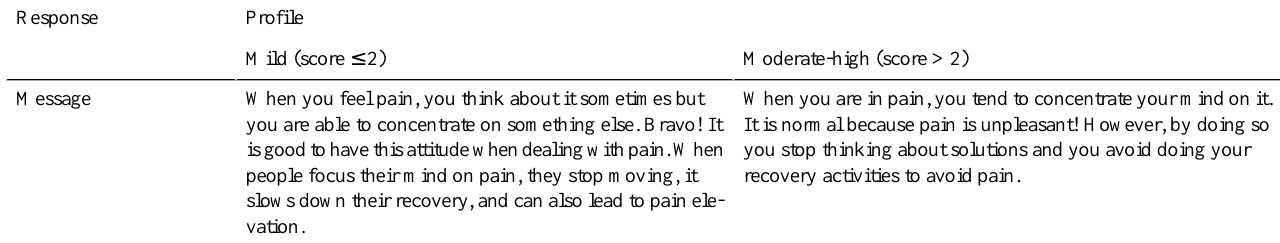
Table 2. Example of tailored message according to score on the Pain Catastrophizing Scale (rumination subscale). ProfileResponse